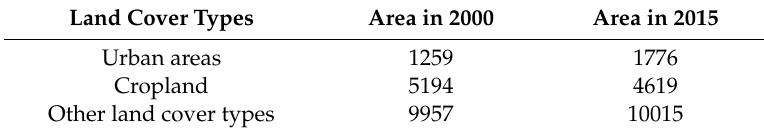
Figure 3. Spatial pattern and statistical information of land cover in Beijing. a and b are the land cover information for 2000 and 2015, respectively; c is the five land cover types derived from land cover changes between 2000 and 2015. Table 1. Area of land cover types in Beijing in 2000 and 2015. The unit of area is km 2 .